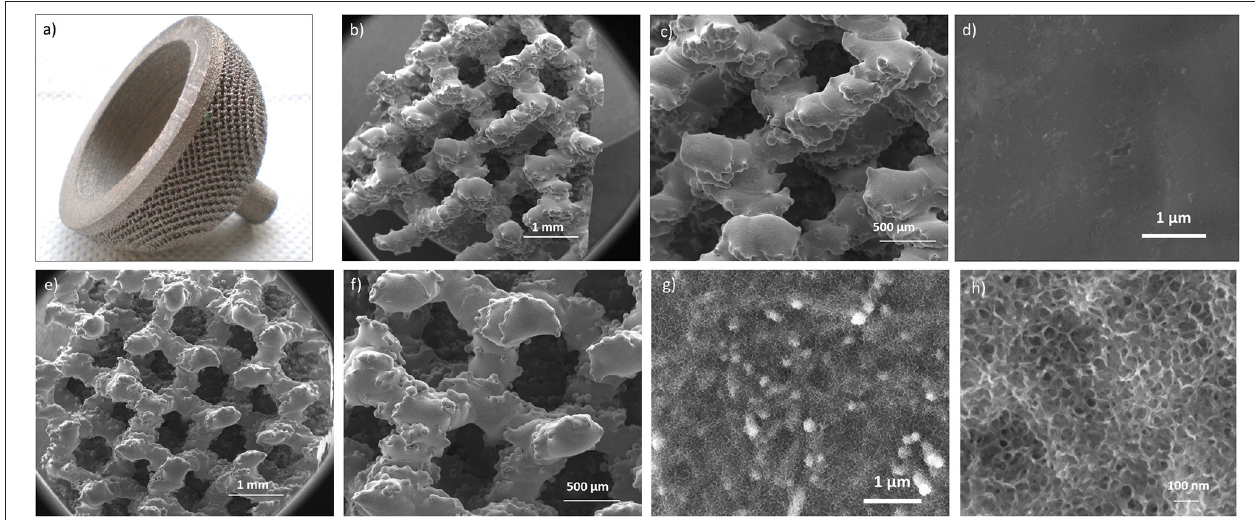
FIGURE 3 | Macroscopic appearance of the untreated cup (a) ; FESEM images of the untreated (b–d) and chemically treated (e–h) samples at different magnifications. In the treated specimens the sponge-like nanotexture resulted as homogeneously distributed onto all the cup surface.